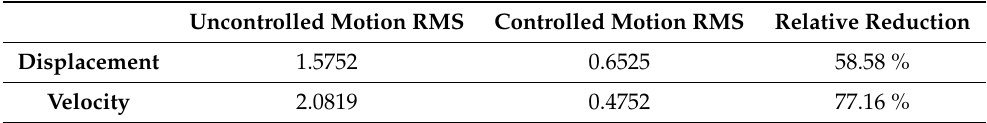
Table 3. Performance of the Optimal Feedback